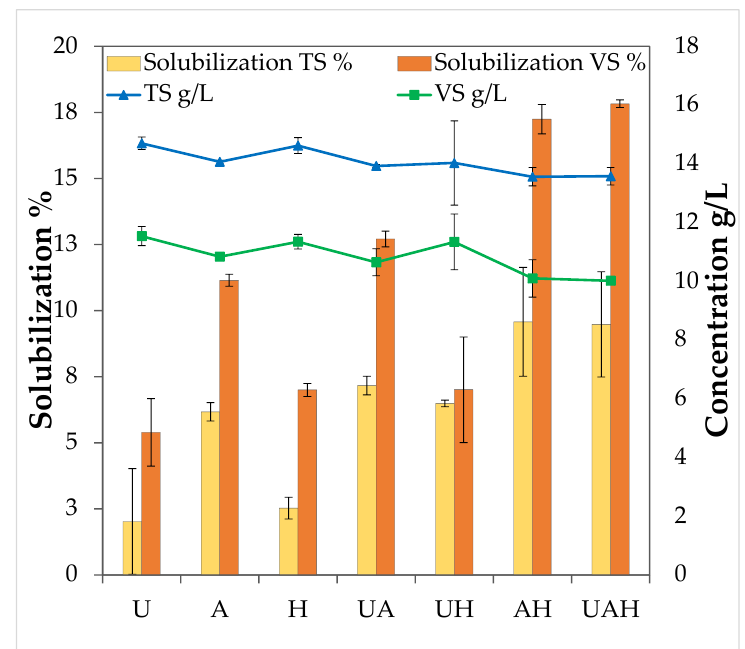
Figure 1. TS and vs. in terms of percentage solubilized and g/L after various pretreatments. U, A, and H represent ultrasonication, alkali, and heating, respectively.